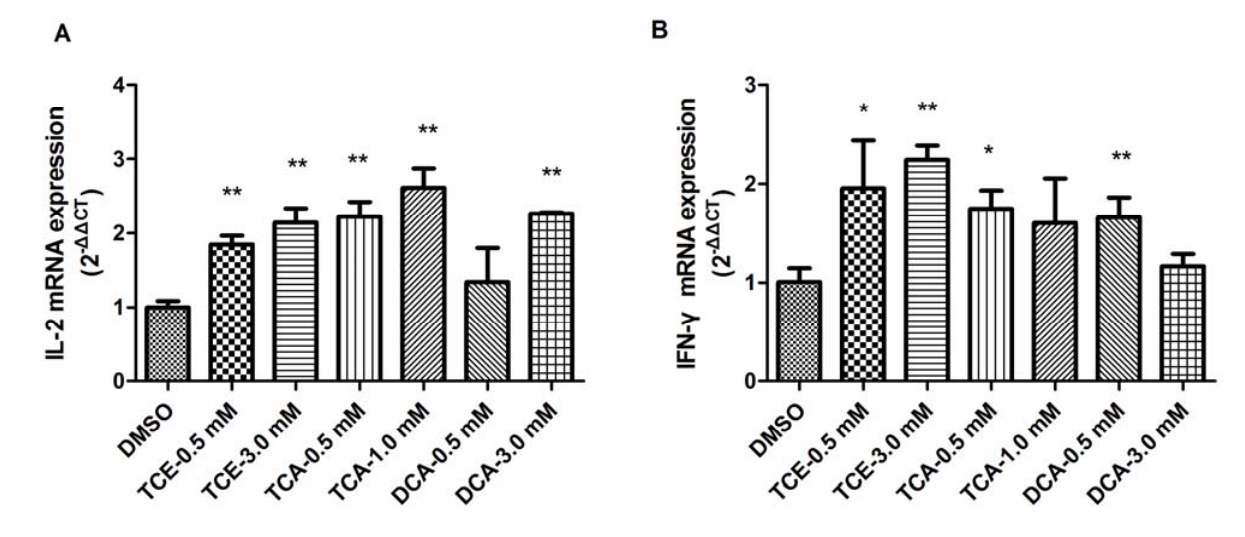
Figure 4. Effect of TCE, TCA and DCA on Th1 cytokine gene expressions in Jurkat cells. Cells were pretreated with TCE (0.5 and 3.0 mM), TCA (0.5 and 1.0 mM) and DCA (0.5 and 3.0 mM) for 16h and then stimulated with PMA(50ng/mL) and Ion (1 mM) for 4 h. The IL-2 ( A ) and IFN- γ ( B ) mRNA expression levels were analyzed by real-time PCR. The bars represent the mean ± SD of three independent experiments. * p < 0.05, ** p < 0.01 compared to the DMSO vehicle control